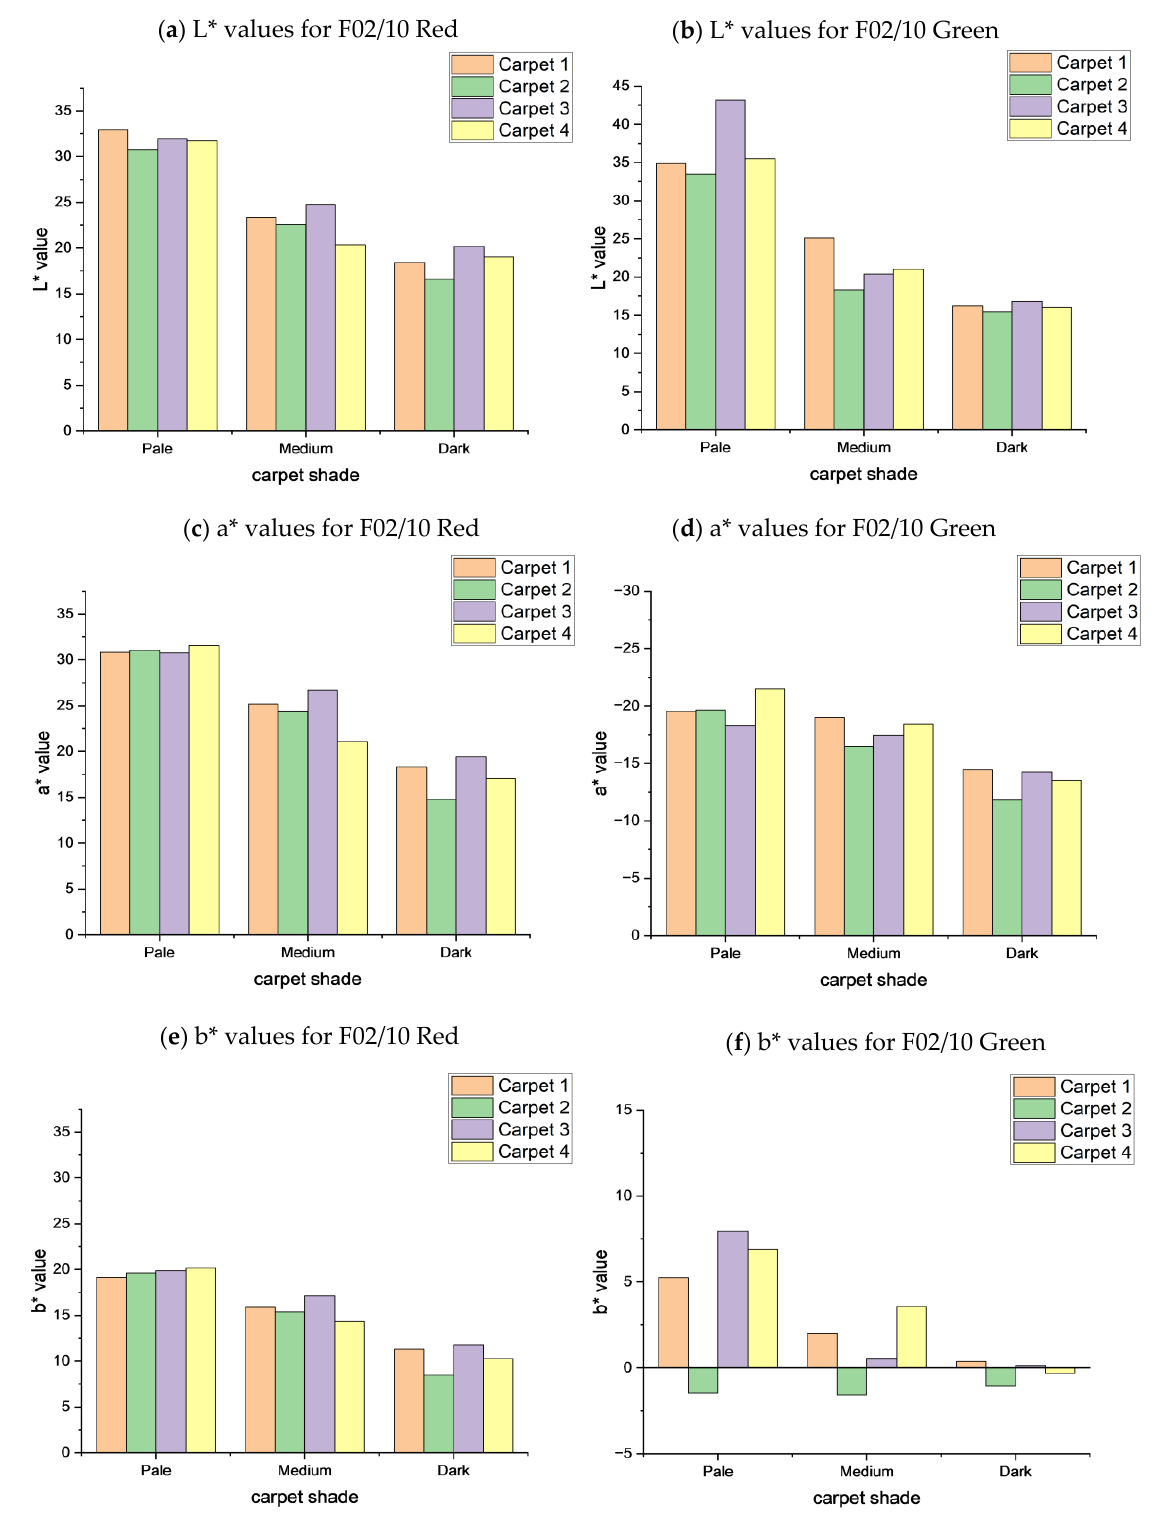
Figure 7. CIE L*, a*, and b* values for F02/10 illumination of different carpets dyed in different shades of red and green colors ( a ) L* values for red-colored carpets ( b ) L* values for green-colored carpets ( c ) a* values for red-colored carpets ( d ) a* values for green-colored carpets ( e ) b* values for red-colored carpets ( f ) b* values for green-colored carpets.